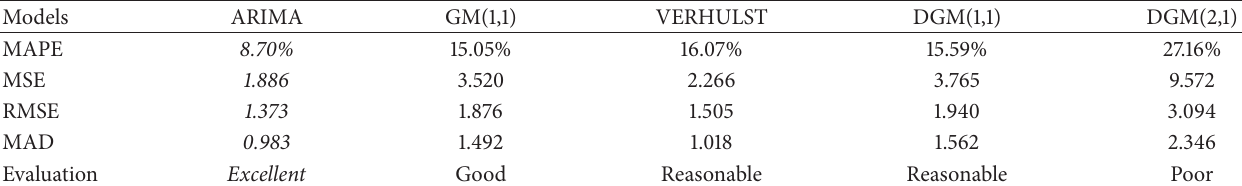
Table 10: Evaluating models with GP forecasting